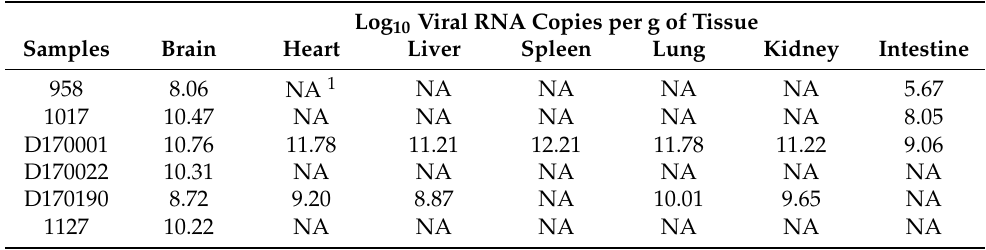
Table 3. Virus RNA quantification of the six Chinese bat rhabdoviruses in different organs from the original infected